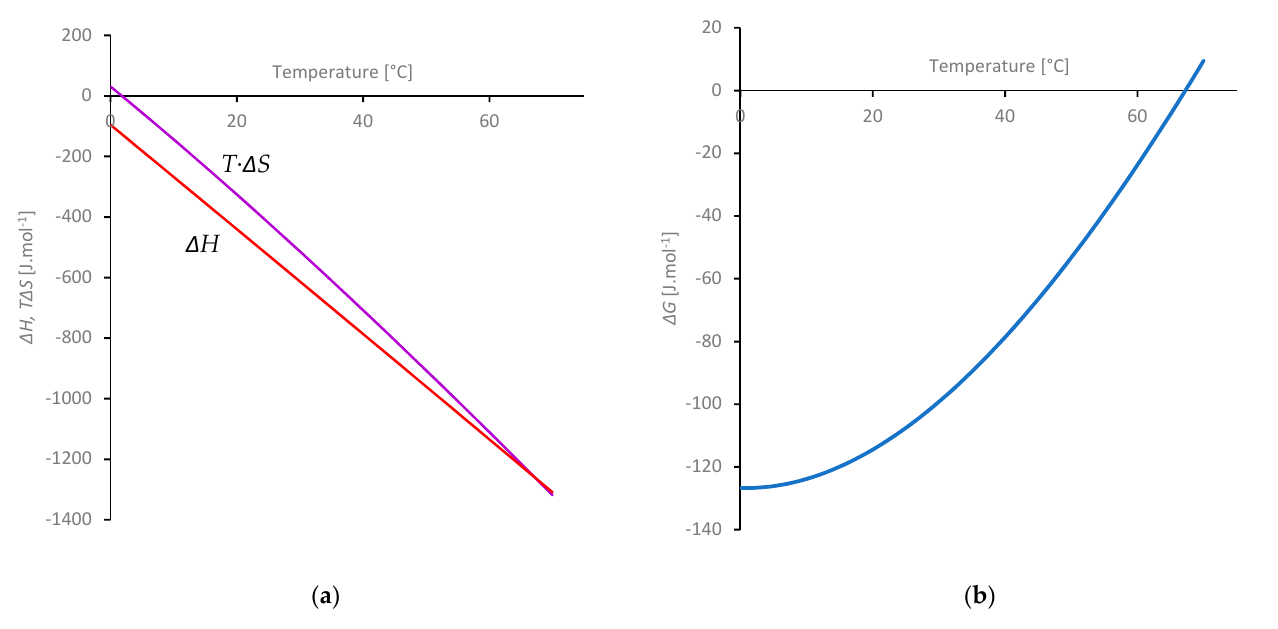
Figure 11. Thermodynamic values for the fibroin hydration shell, relative to free water, derived from the thermodynamic model (Equations (8a), (8b) and (8c)) fitted in Figure 10. ( a ) Enthalpic ( Δ H , red) and entropic ( T. Δ S , purple) components; ( b ) Gibbs free energy change is the difference ( 𝛥𝐺 = Δ𝐻 − 𝑇.Δ𝑆 ) between the plots in ( a ).